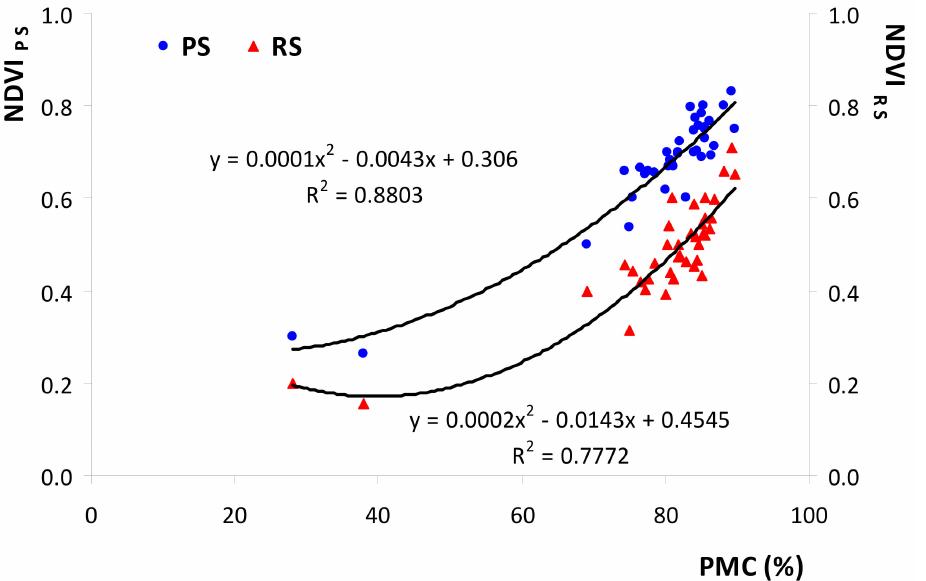
Figure 9. Correlation between vegetation index values (obtained by proximal sensors, NDVI PS , and by remote sensing, NDVI RS ) and pasture moisture content (PMC).